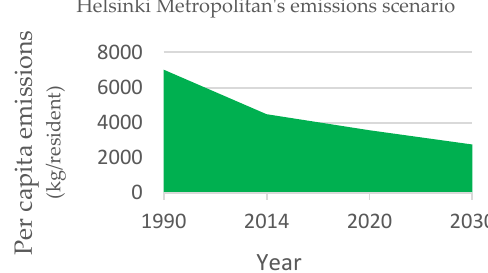
Figure 1. Carbon reduction projection for the city of Helsinki. Note: Figure 1 was created using data Authority (HSY) and the City of Helsinki Environmental Report from 2014.